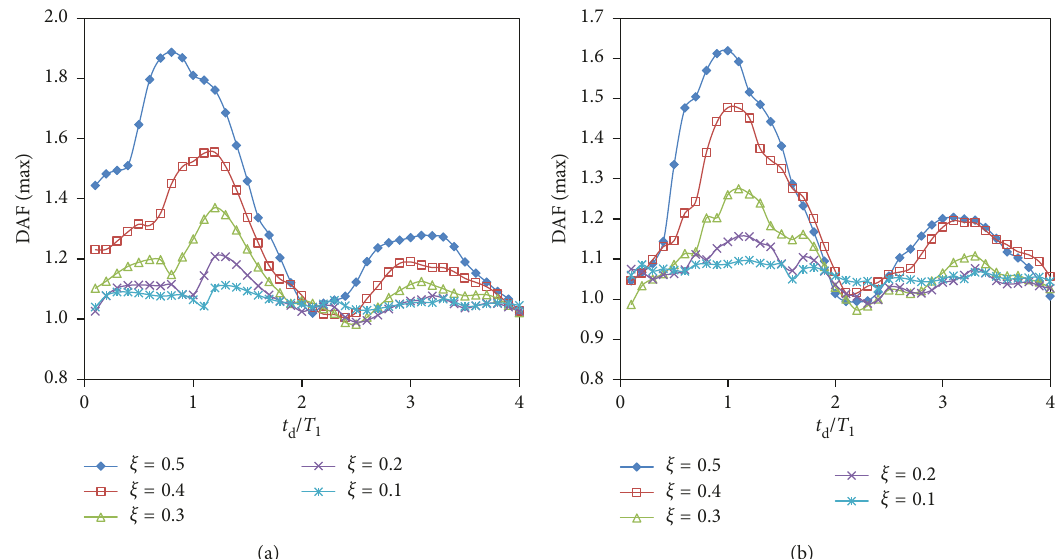
Figure 9: Maximum DAF of shear force of bridge columns under impact load with isosceles triangle shape at different positions. (a) F-F. (b) F-H.